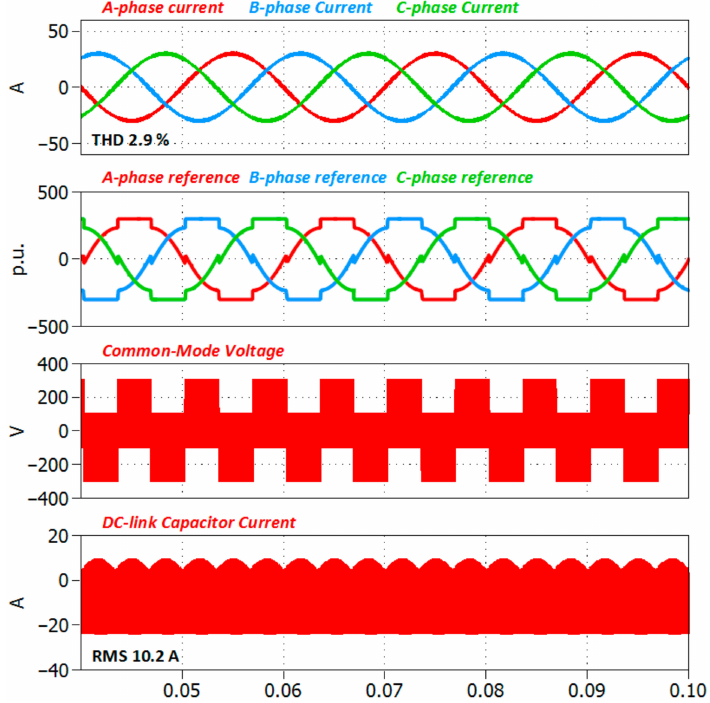
Figure 5. Simulation results of the conventional